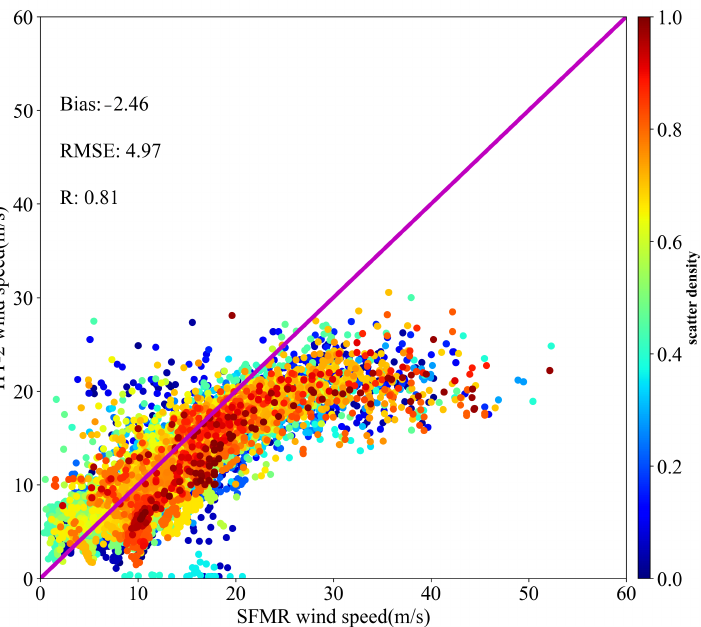
Figure 9. Two-dimensional scatter comparisons of high wind speed between HY-2B/C/D and SFMR from July 2019 to December 2021.